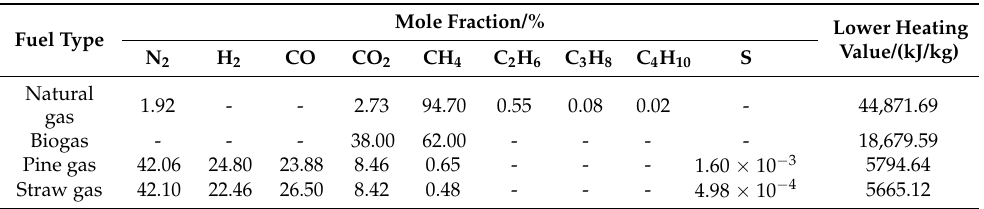
Table 3. Fuel gas